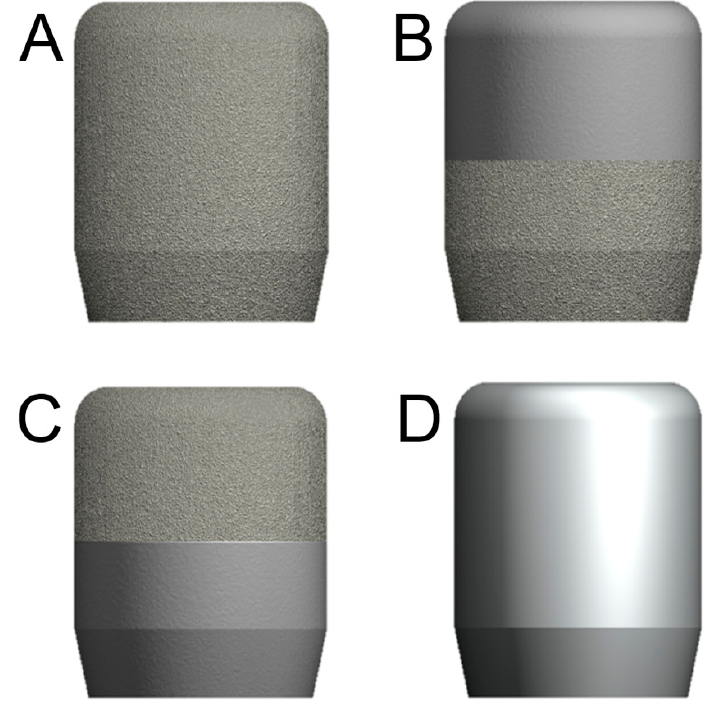
Figure 1. Schematic drawings of the different healing abutments used in this study. ( A ) Direct metal laser sintering (DMLS) healing abutment (T1); ( B ) healing abutment with a smooth surface in the upper half and a DMLS surface in the lower half (T2); ( C ) healing abutment with a DMLS surface in the upper half and a smooth surface in the lower half (T3); ( D ) healing abutment with an entirely smooth (machined) surface.